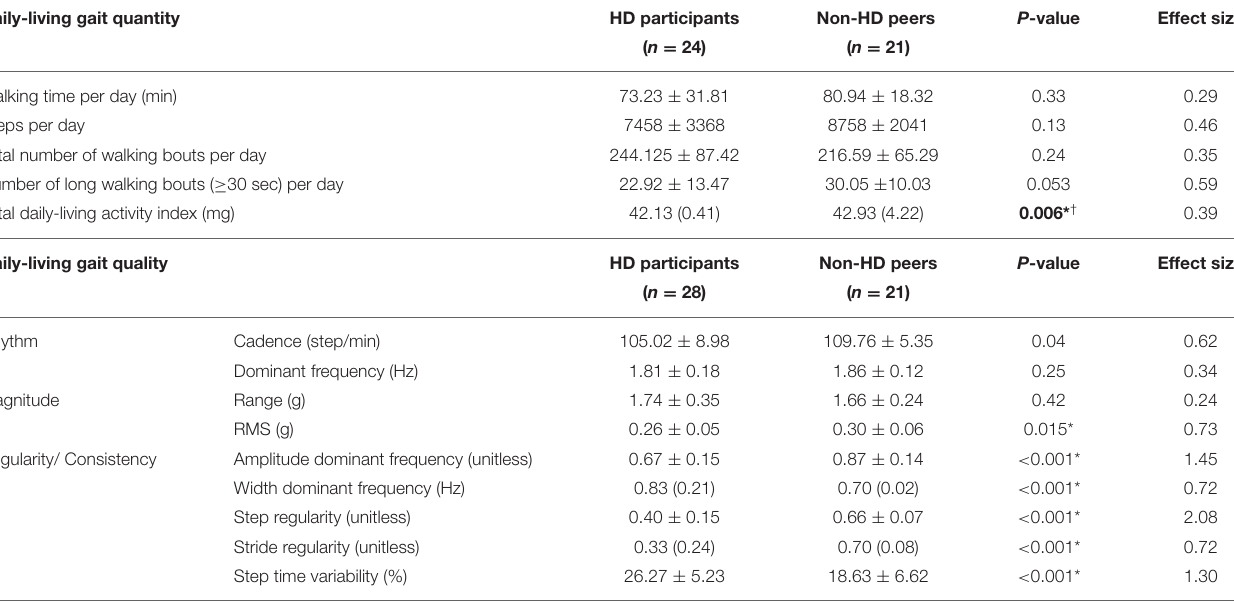
TABLE 2 | Daily-living gait quantity and quality measures in HD and non-HD peers. Daily-living gait quantity HD